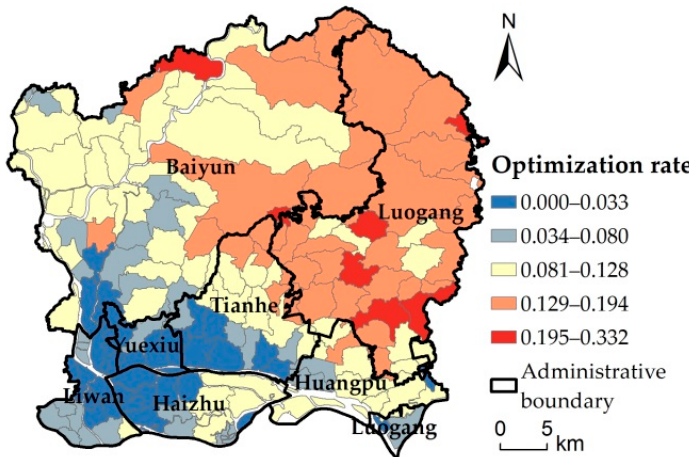
Figure 11. Statistics of impervious surface type before and after optimization.